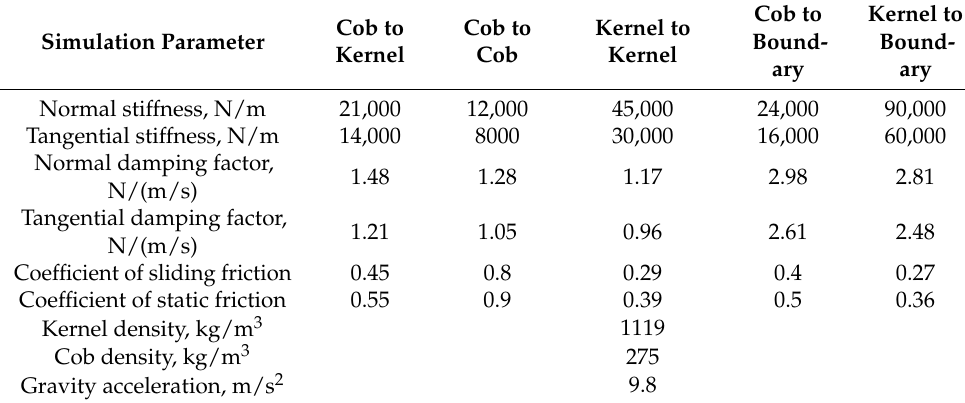
Table 2. Simulation parameters of contact model.